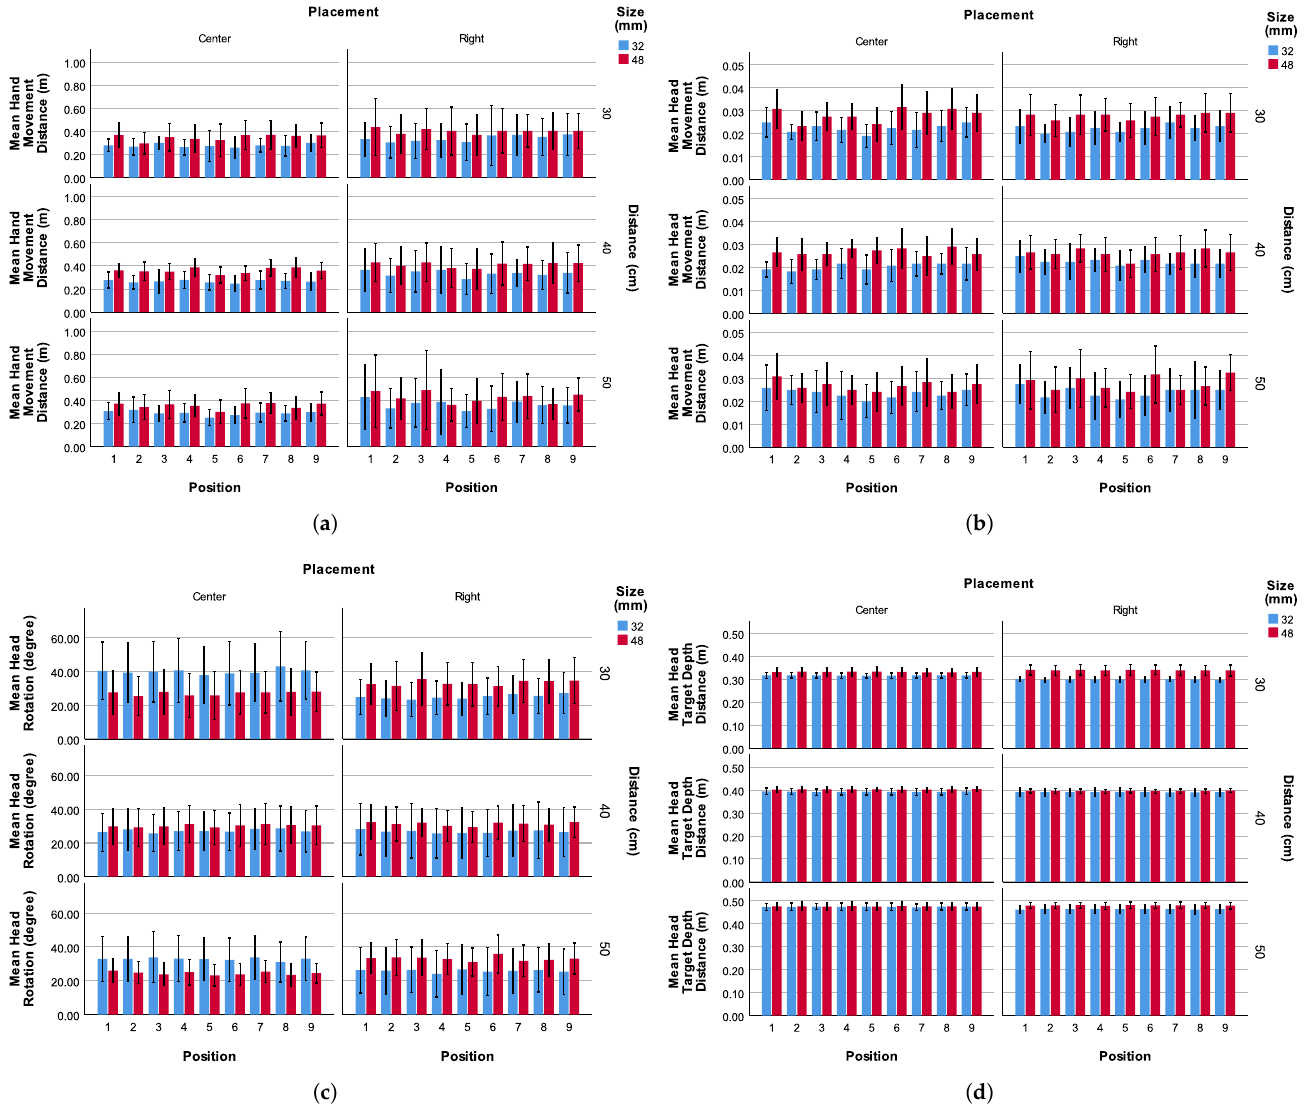
Figure 4. Mean hand movement distance, head movement distance, head rotation degree, and head target distance in the depth dimension. ( a ) Mean hand movement distance; ( b ) Mean head movement distance; ( c ) Mean head rotation degree; ( d ) Mean head target distance in depth dimension.